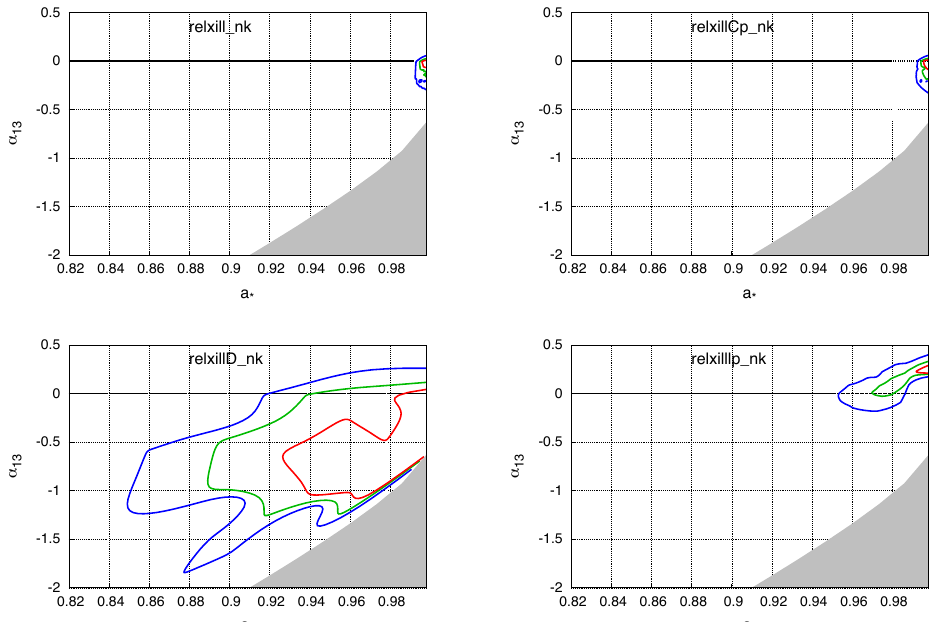
Figure A4. Constraints on the spin parameter a ∗ and the Johannsen deformation parameters α 13 for Ark 120 when the reflection component is modeled by RELXILL _ NK ( top left panel ), RELXILL C P _ NK ( top right panel ), RELXILL D_ NK ( bottom left panel ), and RELXILLLP _ NK ( bottom right panel ). The red, green, and blue curves are, respectively, the 68%, 90%, and 99% confidence level boundaries for two relevant parameters. The grayed regions are ignored in our analysis because the do not meet the condition in